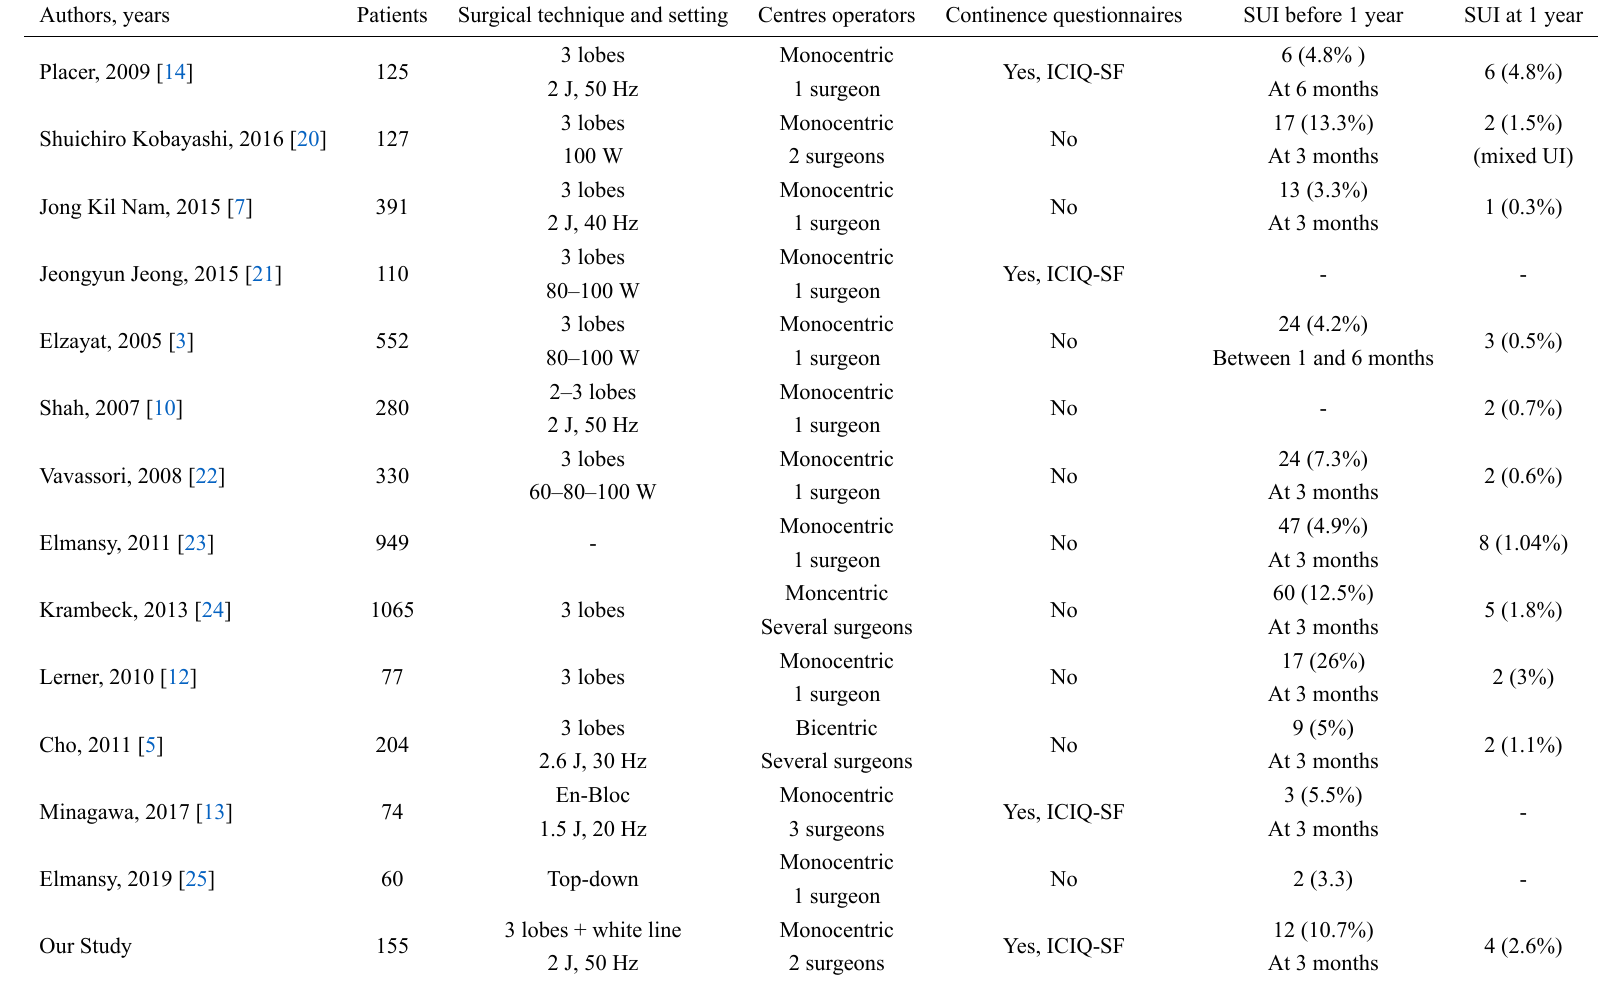
Table 4. SUI rates after HoLEP reported in the